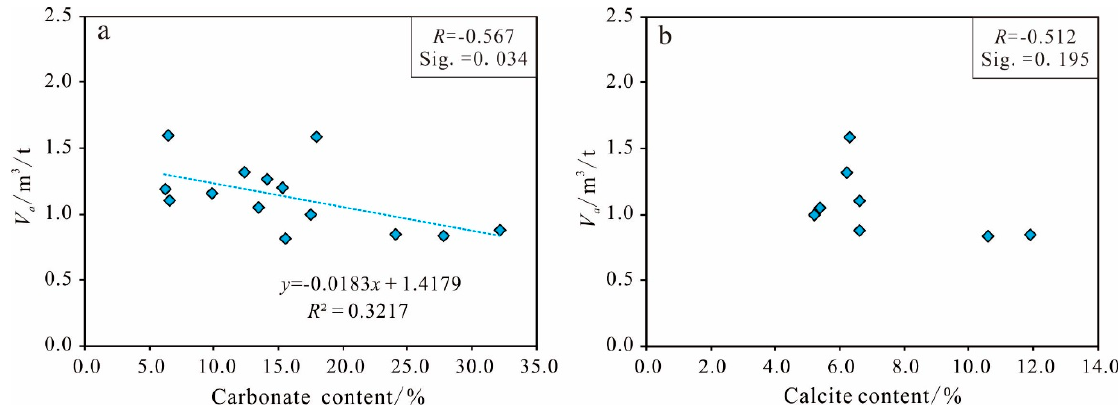
Figure 14. Influence of carbonate mineral content on AGC in shales. ( a ) Negative relationship between V a and the carbonate content; ( b ) no obvious relationship between V a and the calcite content.